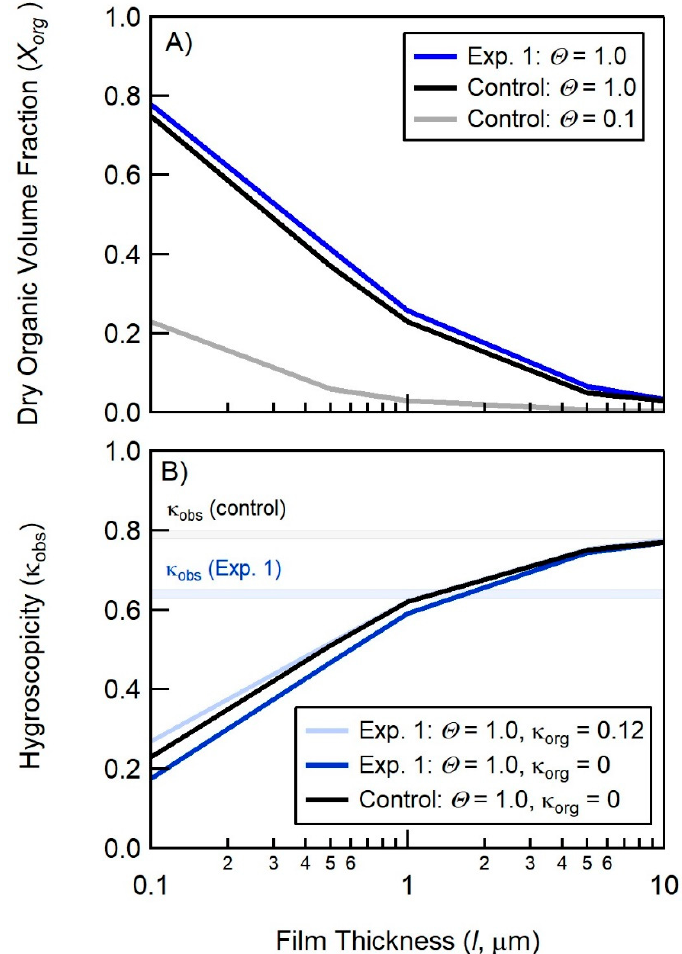
Figure 5. Modeled dependence of the SSA organic volume fraction (panel A, X org ) and hygroscopicity (panel B, κ ) on the fractional surface coverage of palmitic acid on the bubble film cap ( Θ ) and the bubble film cap thickness ( l ) for the addition of palmitic acid and glucose to salt water (Control Experiment, black and gray lines) and the addition of palmitic acid and glucuronic acid to salt water (Experiment 1). The shaded regions in panel B represents the range of measurements of κ .